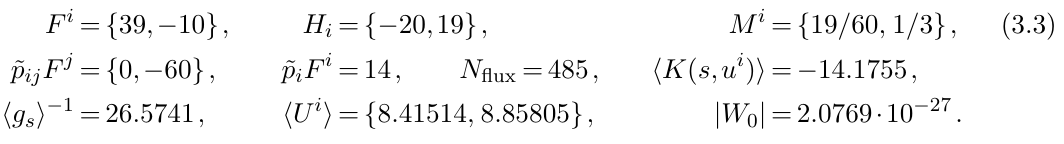
| ’ 2 . 0769 · 10 − 27 as 0